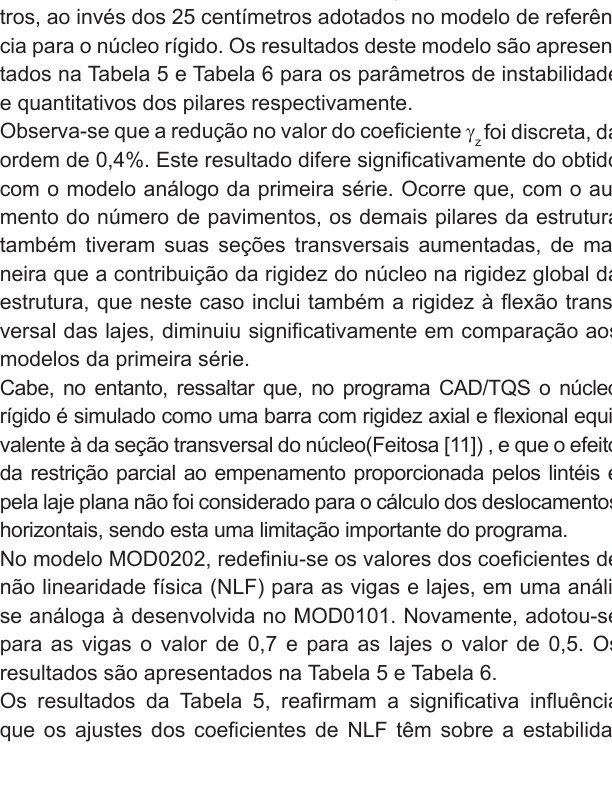
MOD0200 e os resultados dos parâmetros de instabilidade deste modelo são apresentados na Tabela 5 e os quantitativos para os pilares na Tabela 6.